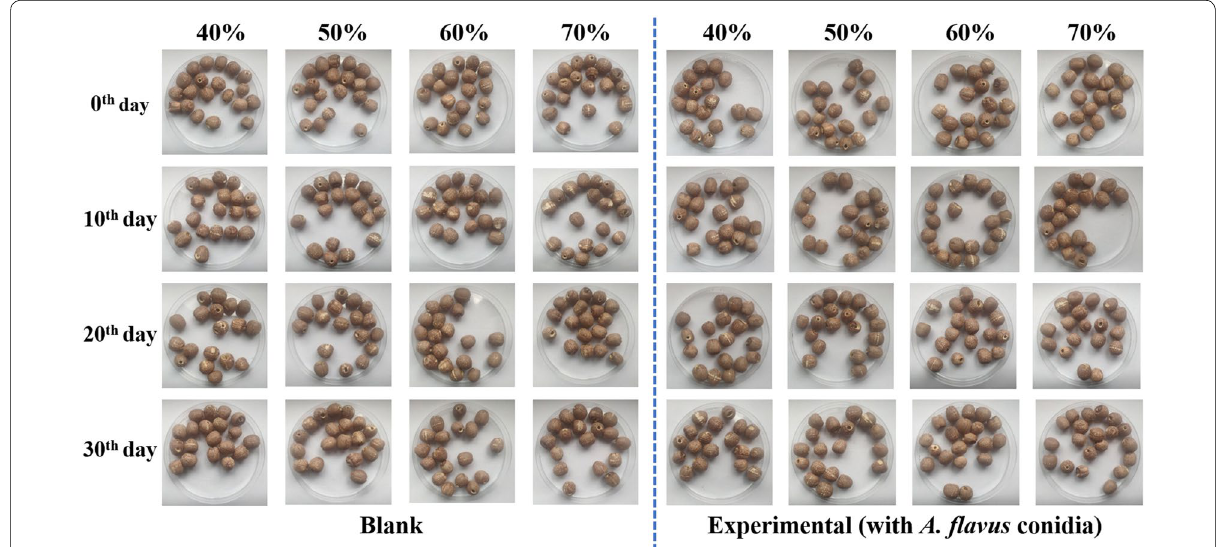
Fig. 4 Mildew changes of lotus seed stored at 25 °C and different relative humidity conditions (40%, 50%, 60% and